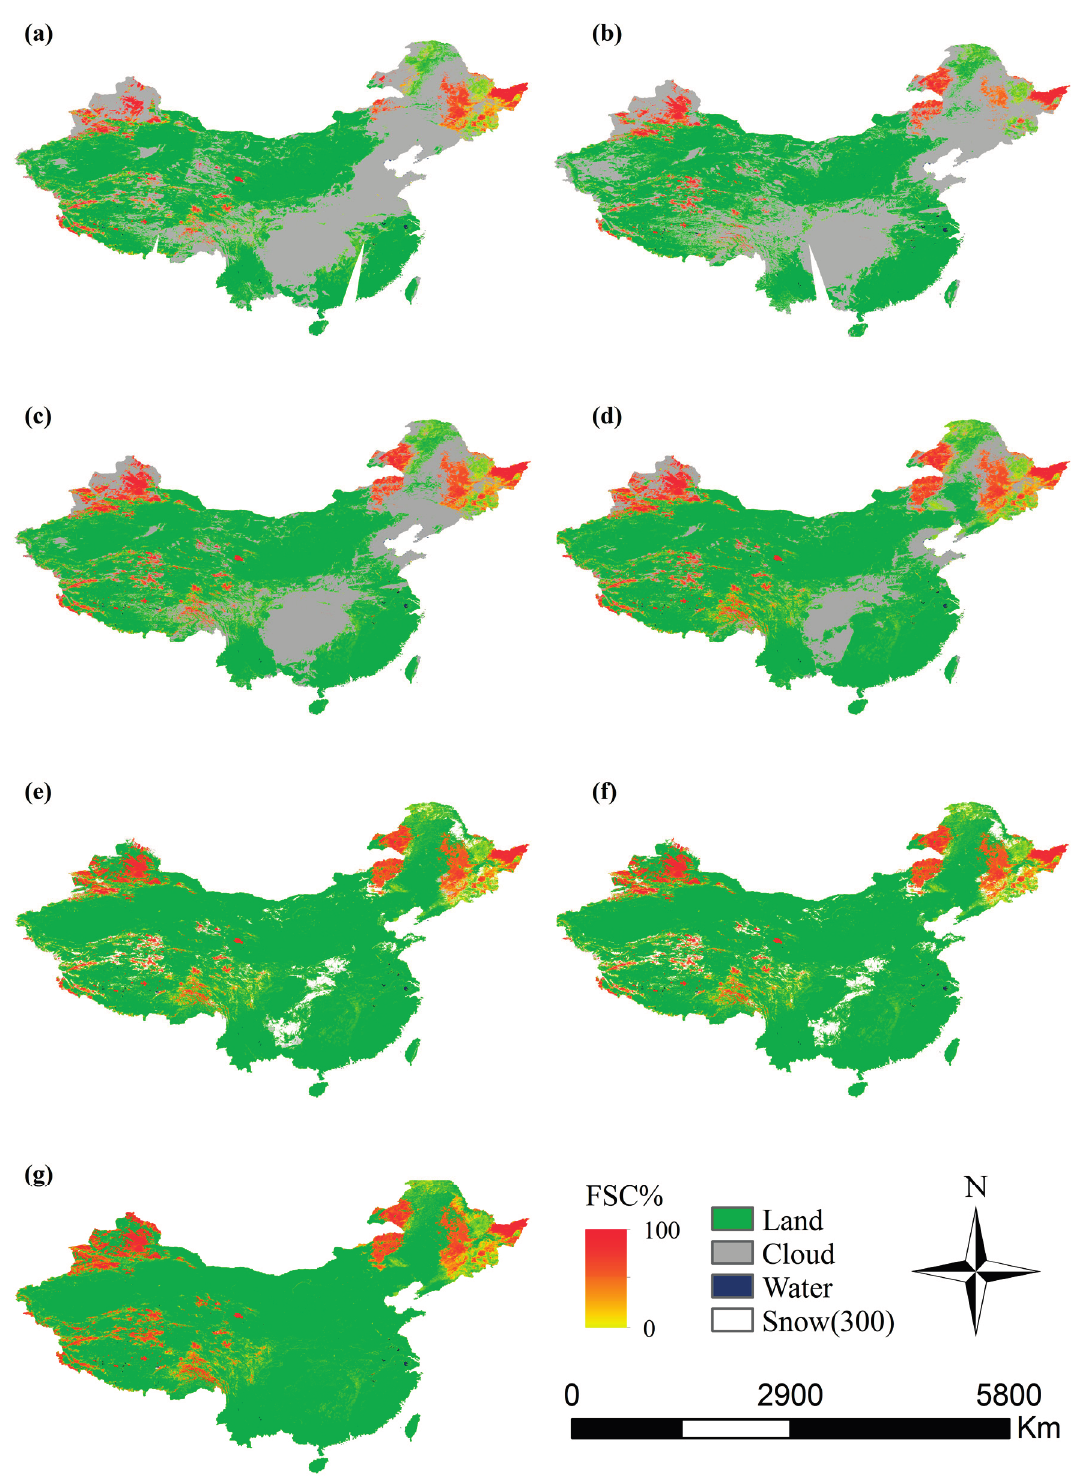
Figure 4. Cloud cover map on 16 January 2014. ( a ) MOD10A1; ( b ) MYD10A1; ( c ) composite morning and afternoon map; ( d ) day-before-and-after composite map; ( e ) SNOWL with cloud removed; ( f ) composite map with AMSR2; ( g ) daily cloud-free FSC